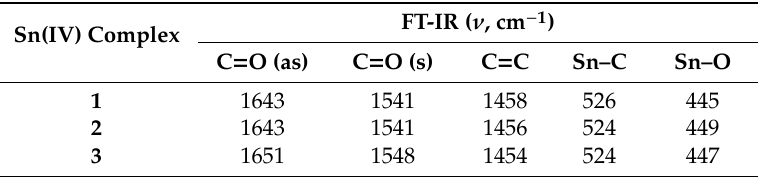
Table 2. Selected FT-IR spectral data for Sn(IV) complexes 1 – 3 .